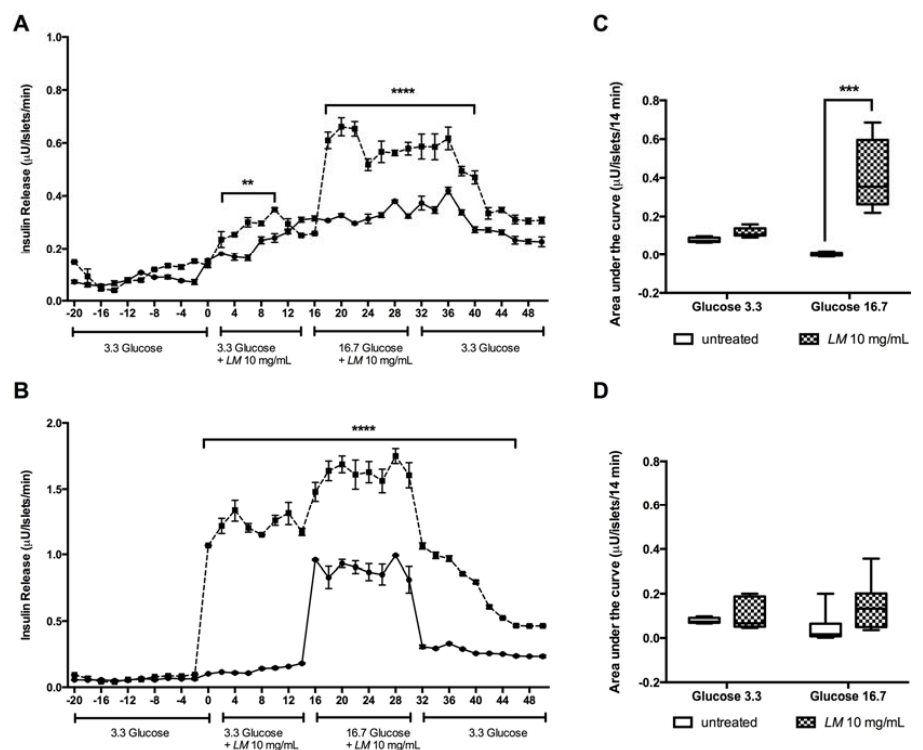
Figure 5. LM induces in vitro insulin release in perifused islets. Batches of 40–50 islets from GK ( A ) and W rat ( B ) were perifused with low glucose (3.3 mM), from time 0 to 14 min, and with high glucose (16.7 mM), from time 16 to 30 min, in presence ‐‐‐ ▪ ‐‐‐ or absence – • – of LM (10 mg/mL). The AUC of the insulin release from the intervals in low and high glucose, in the presence or absence of LM were calculated; GK rat ( C ) and W rat ( D ) islets. Data are presented as means ± standard error of the mean SEM ( n = 4). ** p < 0.01, *** p < 0.001, **** p < 0.0001 when compared to untreated islets.